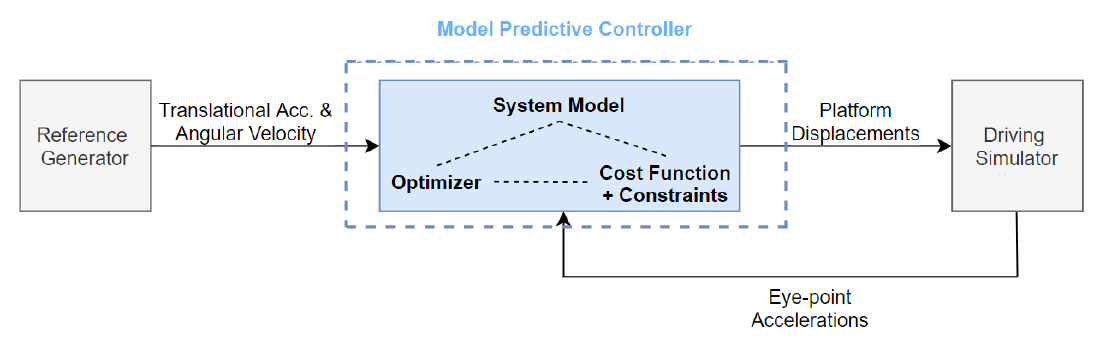
Figure 3. Scheme of MPC-based